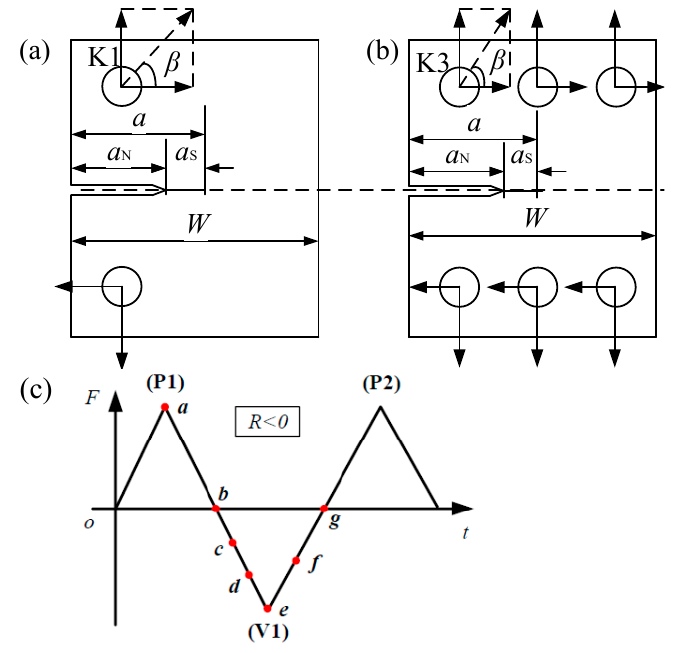
Figure 1. Sketch map of specimen and loading: ( a ) K1 specimen, ( b ) K3 specimen, ( c ) fatigue loading. Two notch lengths are considered in this paper: a n = 0 and a n / a s = 4. The specimen with a n = 0 is represented by K-S, and the specimen with a n / a s = 4 is represented by K-N. Two different loading conditions are considered in this paper, as shown in Figure 1. There are: The loading points are located on both sides of the crack surfaces in Figure 1a, which shows a high constraint state; The loading points are uniformly distributed over the width of the specimen in Figure 1b, which shows a low constraint